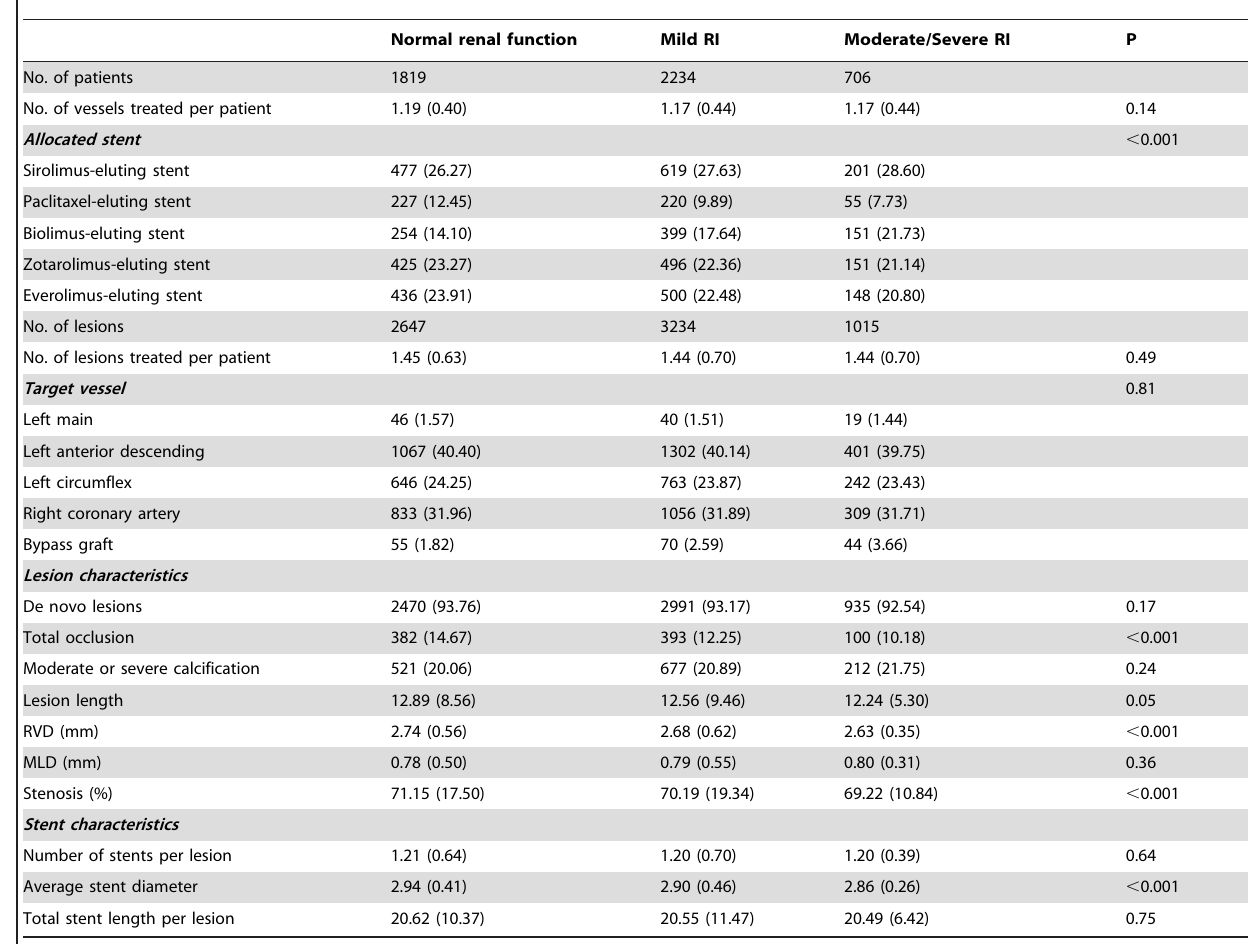
Table 2. Angiographic and Procedural Characteristics at